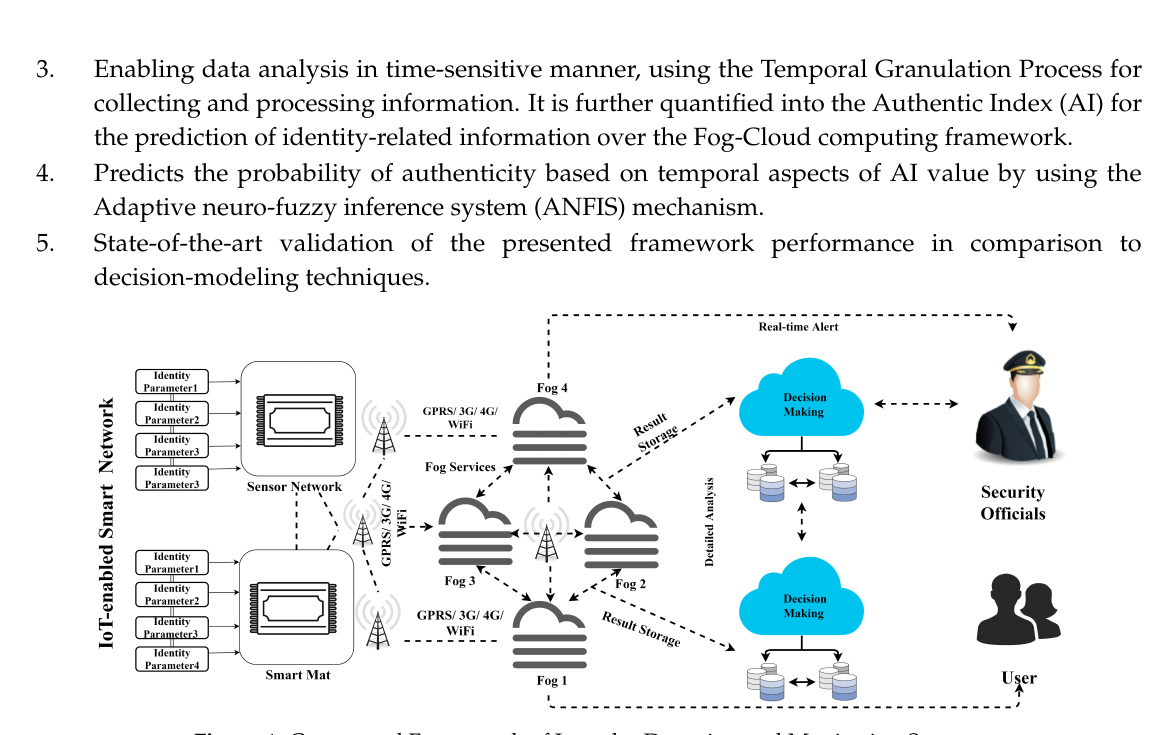
Figure 1. Conceptual Framework of Intruder Detection and Monitoring